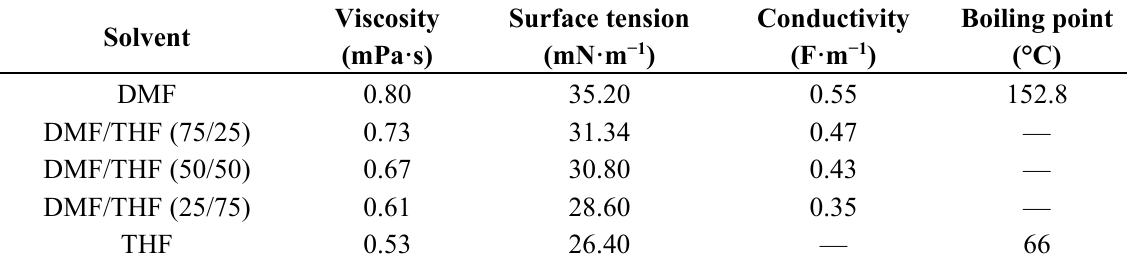
Table 1. Basic properties of solvents a .